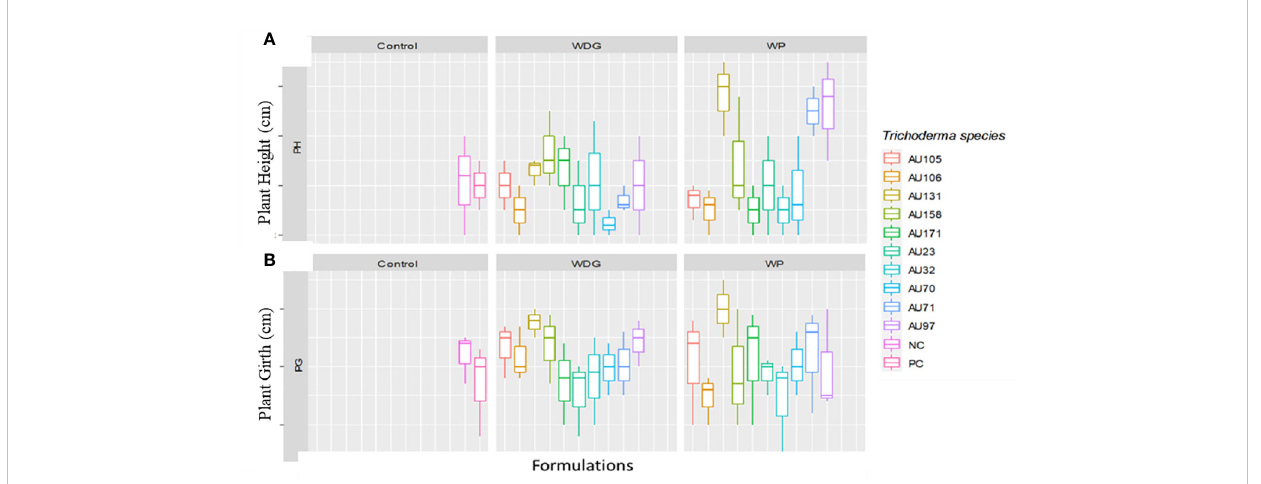
FIGURE 8 Boxplots of plant growth parameters for coffee seedlings treated with Trichoderma bioformulations. Trichoderma isolates: T. viride AU23, T. longibrachiatum AU32, T. koningiopsis AU70, T. asperelloides AU71, T. asperellum AU97, T. harzianum AU105, T. aethiopicum AU106, T. asperellum AU131, T. longibrachiatum AU158 and T. asperellum AU171. (A) Plant height and (B) plant girth. WP, Wettable Powder; WDG, Water Dispensable Granules; PC, Positive control and NC, Negative control. The boundaries of the boxplots indicate the 25 th and 75 th percentiles, and the solid line within the boxes indicates the median value.